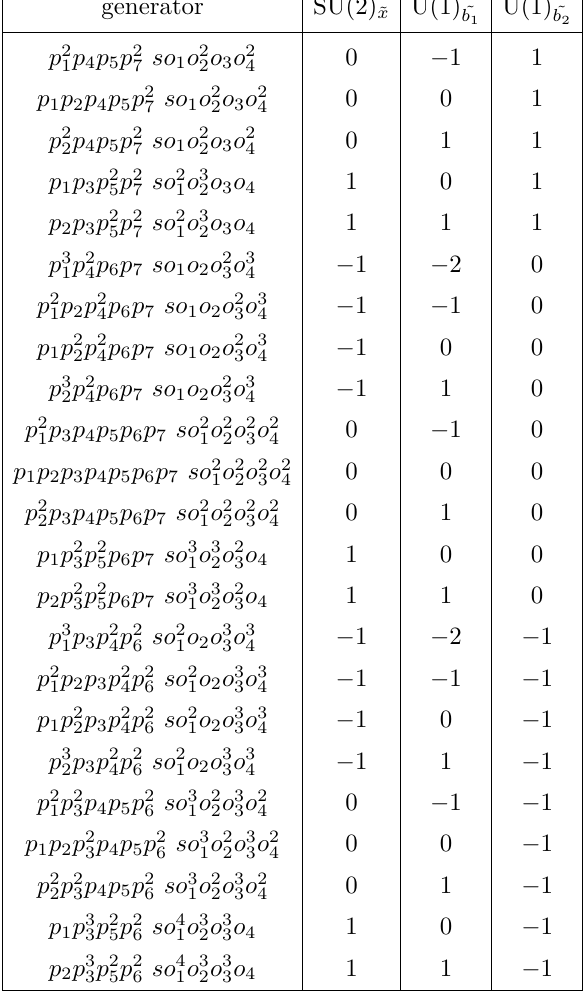
Table 52 . The generators and lattice of generators of the mesonic moduli space of Model 13 in terms of brick matchings with the corresponding flavor